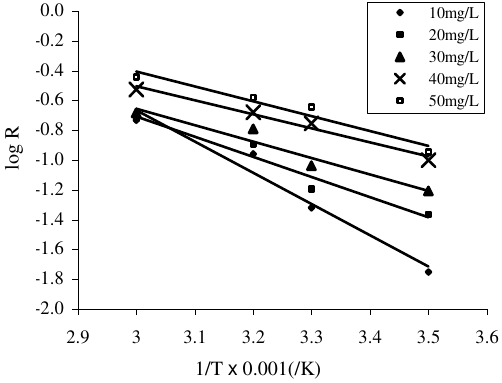
Figure 6. Arrhenius plot for the adsorption of various concentrations of Pb 2+ onto human hair Table 3. Thermodynamic parameters and activation energy for the adsorption of Zn 2+ onto human